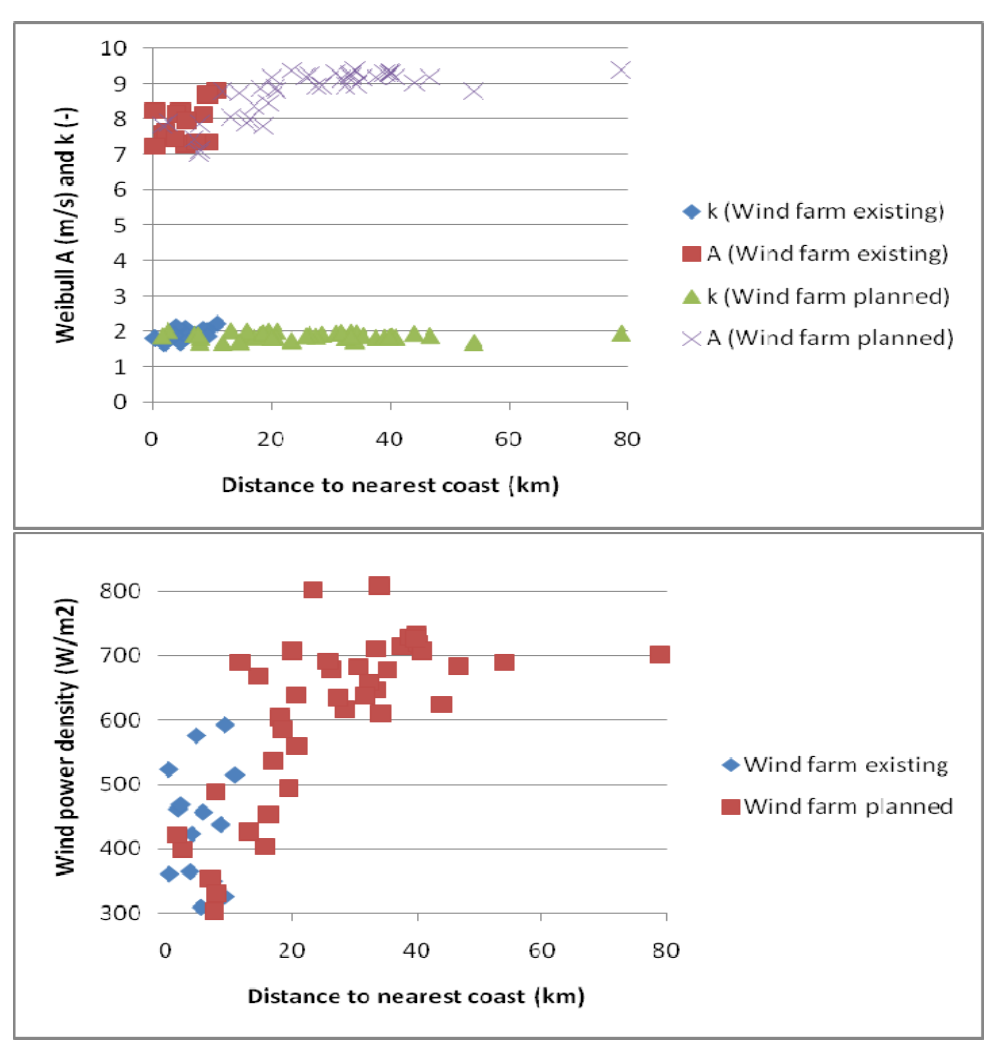
Figure 12. Weibull A and k (top) and wind power density (bottom) calculated from Envisat ASAR observations at existing and planned wind farms in the study